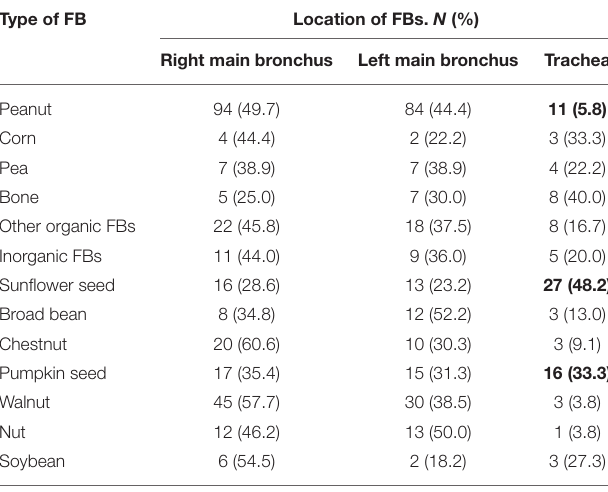
TABLE 2 | Distribution of type of foreign bodies (FBs) by